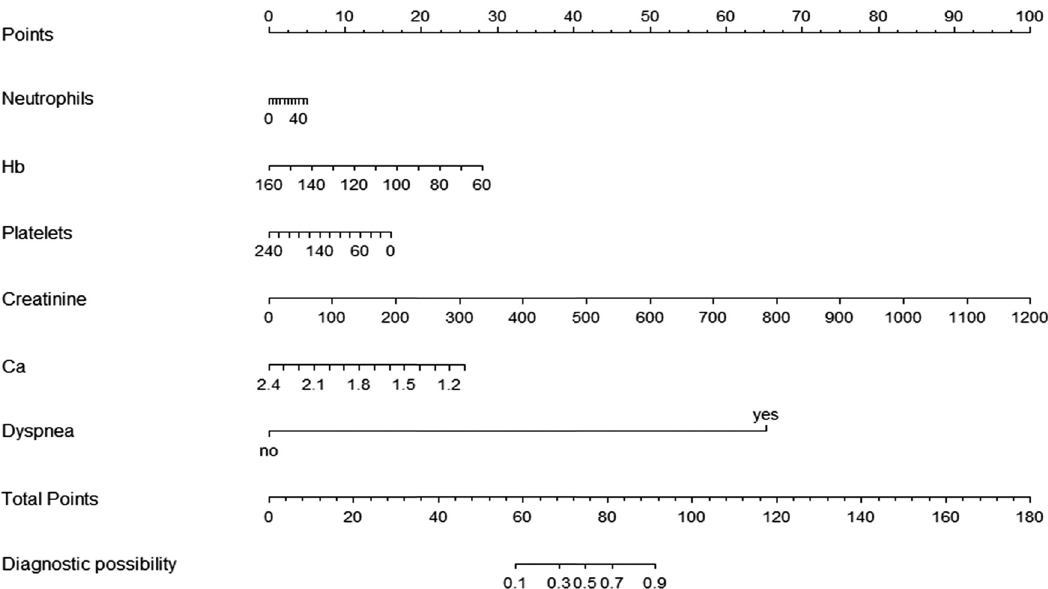
Figure 2: Nomogram to predict the risk of severity in patients with HFRS. To use the nomogram in clinical practice, a line can be drawn up to calculate the patient ’ s total score by the value of each predictor variable, and then, a line can be drawn down based on the total score to fi nd out the possibility of severe HFRS. HFRS, hemorrhagic fever with renal syndrome; Hb, hemoglobin; Ca, calcium.